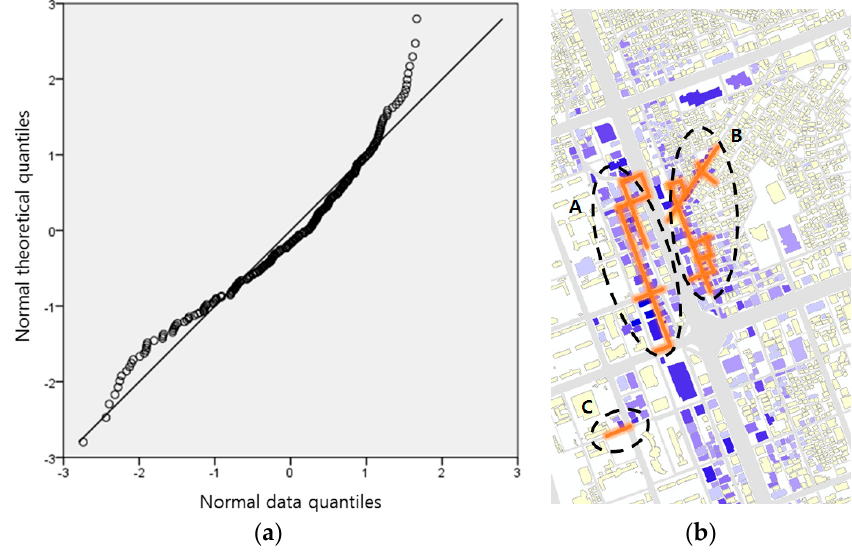
Figure 12. Gangnam area test results: ( a ) Q-Q plot for normal; ( b ) Restaurant themed streets.